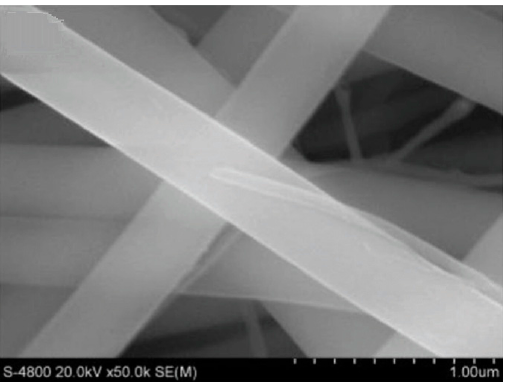
Figure 10. SEM image of the electrospun mullite fibers after calcination at 800 °C